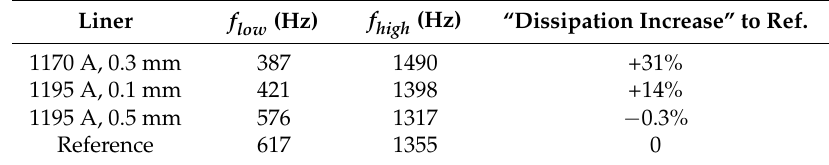
Table 3. Comparison of damping curves (only dissipation data above ∆ = 0.3 is considered here). 1170 A, 0.3 mm Liner 𝒇 𝒍𝒐𝒘 (Hz) 𝒇 𝒉𝒊𝒈𝒉 (Hz) “Dissipation Increase” to Ref.